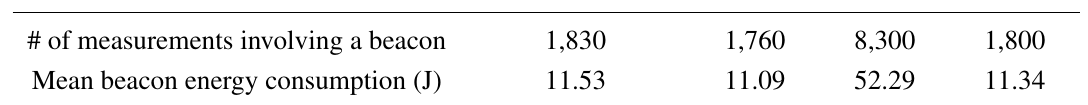
Table 4. Comparison of beacon energy consumption of Method1 , Method2 , Method3 and the proposed scheme during the